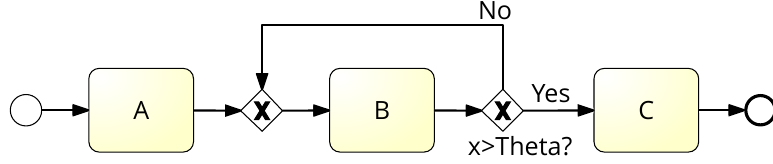
Figure 3. Example of a clinical